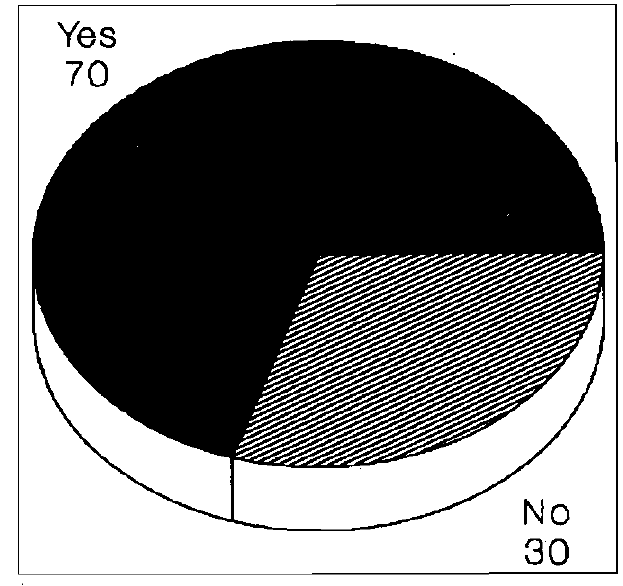
Figure 1. Affected by Sociocultural